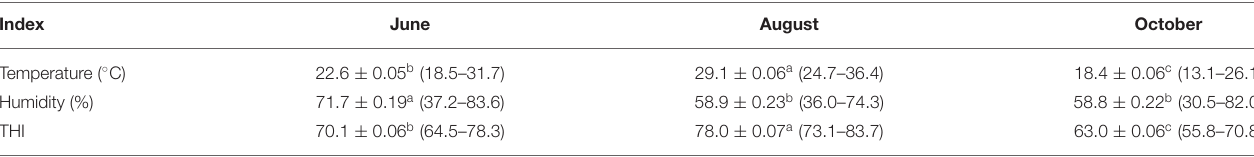
TABLE 2 | Ambient temperature, relative humidity, and THI during the experimental periods.